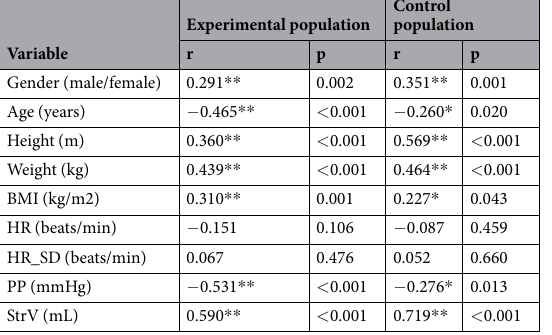
Experimental population